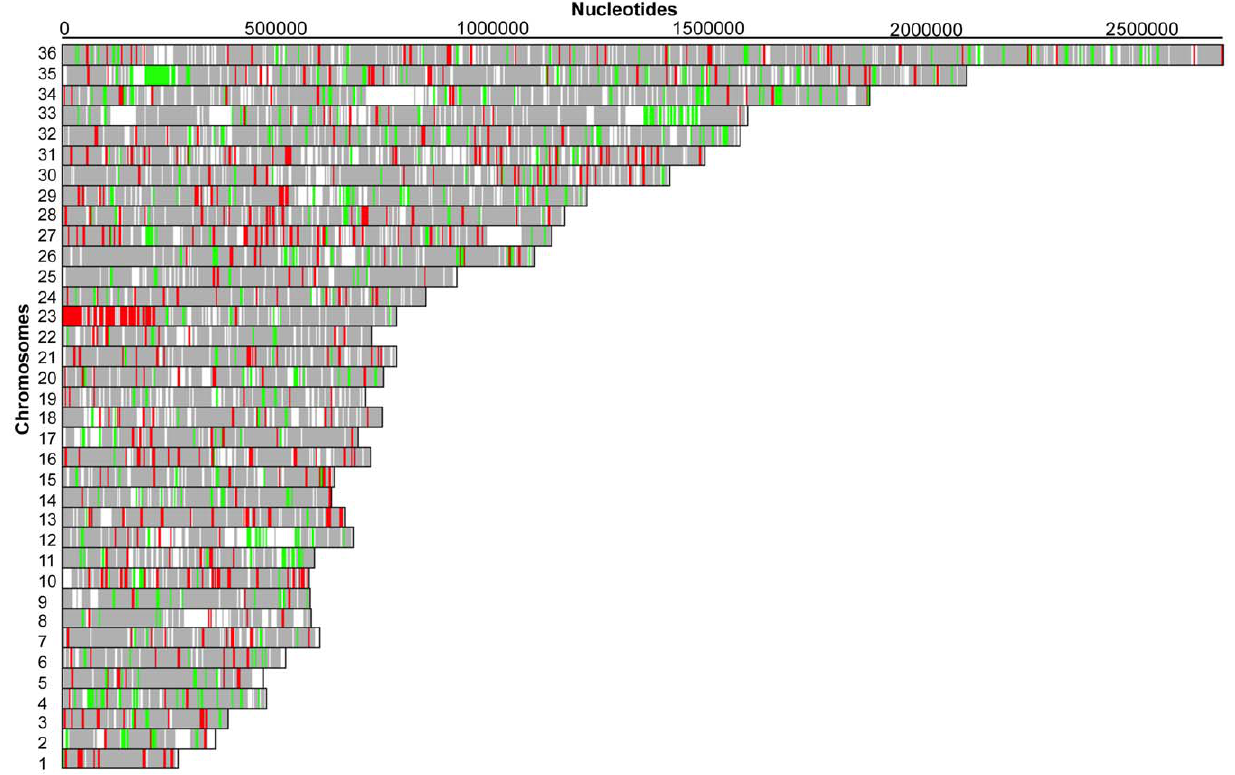
Figure 2. Gene expression map of L.amazonensis Ba199 Sb III 2700.2/WT. DNA microarrays data were analyzed by custom R programs to illustrate the expression profile of Ba199Sb III 2700.2/WT by extrapolating on a chromosome map of L. major. Red lines indicate upregulated genes in Ba199 Sb III 2700.2, whereas green lines indicate downregulated genes. Gray features indicate genes equally expressed in both samples while white regions have not hybridized to probes.